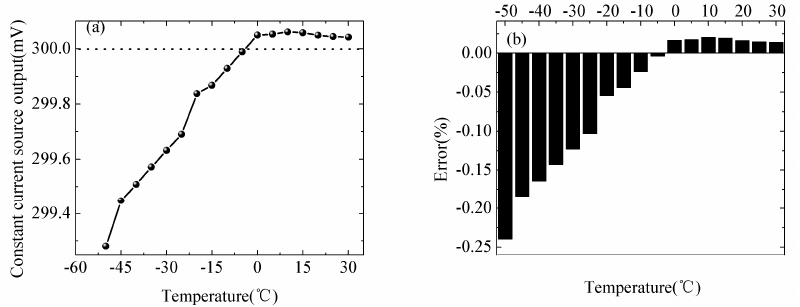
Figure 5. Temperature dependence of ( a ) the output of the constant current source (the measured current values were converted into voltage values), ( b ) error of the output.